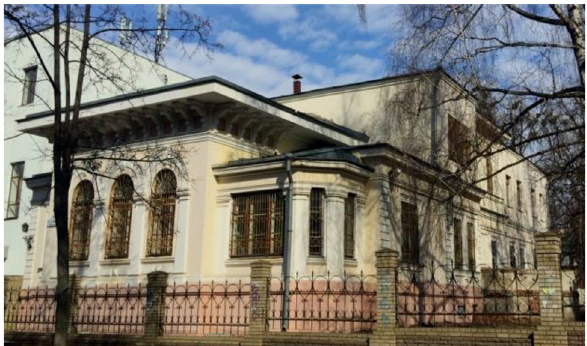
Figure 1. Main facade of the building, modern